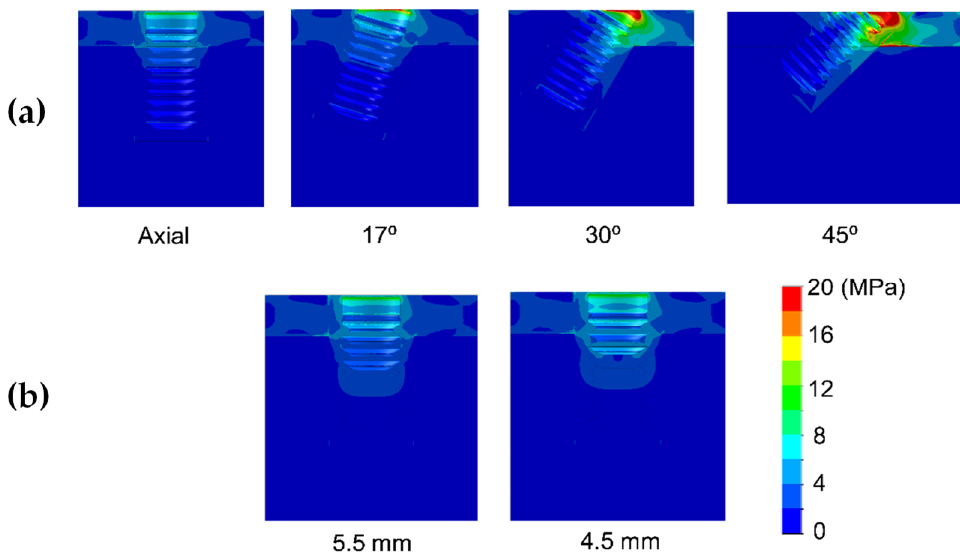
Figure 8. Von Mises stress distribution of delay-loaded long 10 mm implant ( a ) and short implants (4.5 and 5.5 mm in length) ( b ) in bone type II.